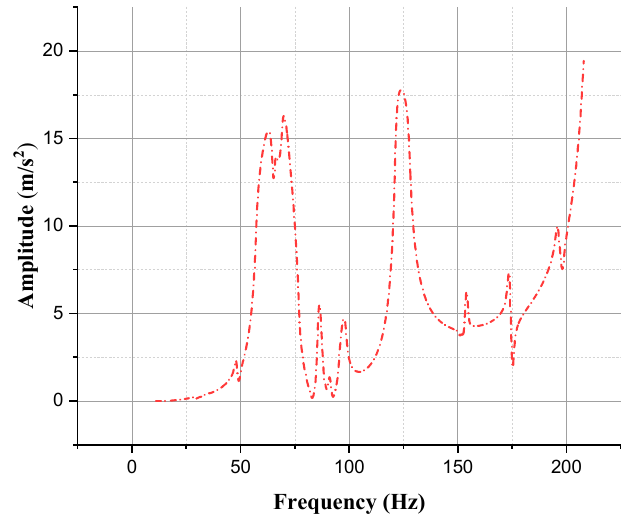
Figure 5. Spectrum analysis result X -axis directions.